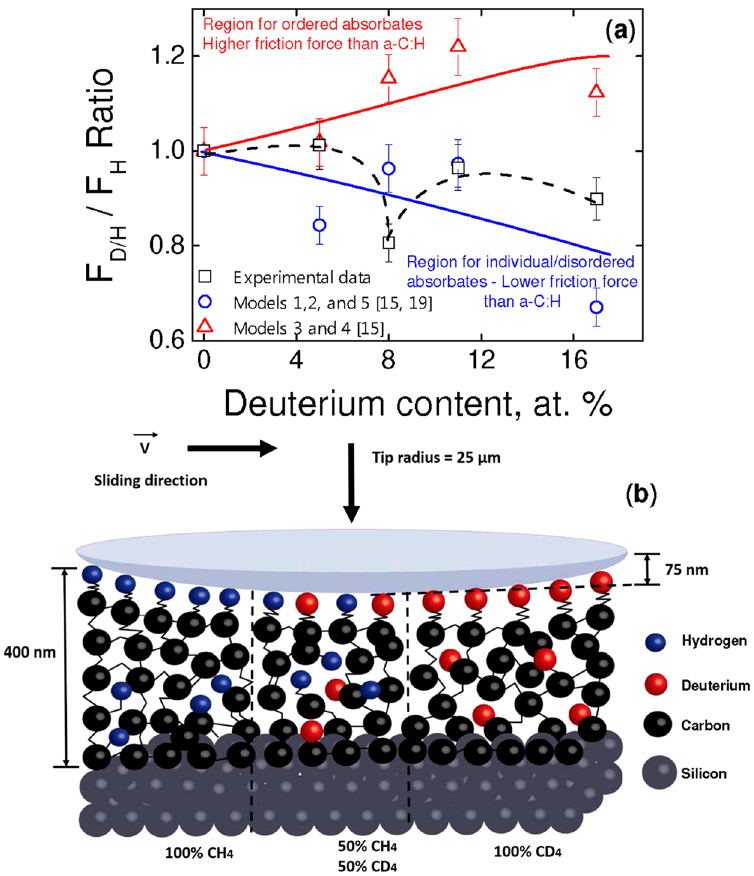
Figure 5. ( a ) F H/D /F H experimental ratio as a function of deuterium content (empty black squares). The empty red triangles correspond to the ordered commensurate adsorbate layer models for transverse (model #3) and longitudinal vibrations (model #4) and the empty blue circles correspond to the single adsorbate (model #1 and 2) and disordered adsorbate distribution (model #5) models after the calculations of F H/D /F H ratio by using the parameters provided from these models. The solid lines represent the average tendency. The experimental data follow a dashed line Y-type (guide for the eyes) and fall in the region of models #1, 2, and 5. All the values were corrected by a contact area factor. ( b ) Schematic (not in scale) of the sliding of a diamond spherical dome on three different a-C:D/H thin